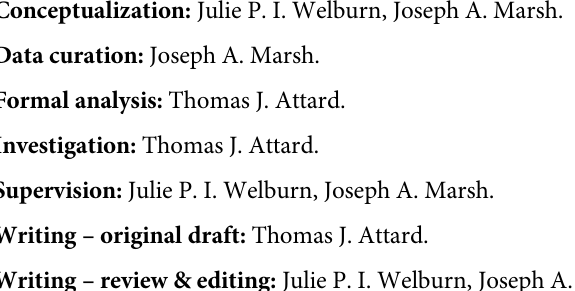
S5 Table. Mean cumulative distribution scores. Ranking of mean cumulative distribution (MCD) scores for all pathogenic tubulin mutations. (CSV) S6 Table. Tubulin residue interactions. All tubulin residues found to be interacting with GTP (or its analogues), MAPs, or with other tubulin subunits (interdimer or intradimer). (CSV) S7 Table. Predicted effects on protein stability for tubulin mutations. All ΔΔ G values pre- dicted using FoldX using both the structure of the monomeric subunit (ddG_fold) and the full biological assembly (ddG_full). (CSV) S1 Data. Multiple sequence alignment. Multiple sequence alignment of all tubulin- α and β isotypes considered in this